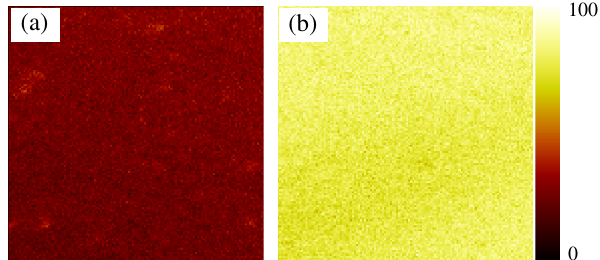
FIG. 6. Positive ion SIMS images obtained from (a) 7000 cou- lomb and (b) 1000 coulomb samples showing relative Cs con- centrations. The total number of Cs ion counts are, respectively, 4 : 33 (cid:4) 10 5 and 1 : 295 (cid:4) 10 6 , consistent with RBS data that determined the Cs surface concentrations to be 1 : 75 (cid:4) 10 15 at = cm 2 for the 1000 coulomb sample and 0 : 4 (cid:4) 10 15 at = cm 2 for the 7000 coulomb sample. The field of view in both (a) and (b) is 150 (cid:3) m (cid:4) 150 (cid:3) m